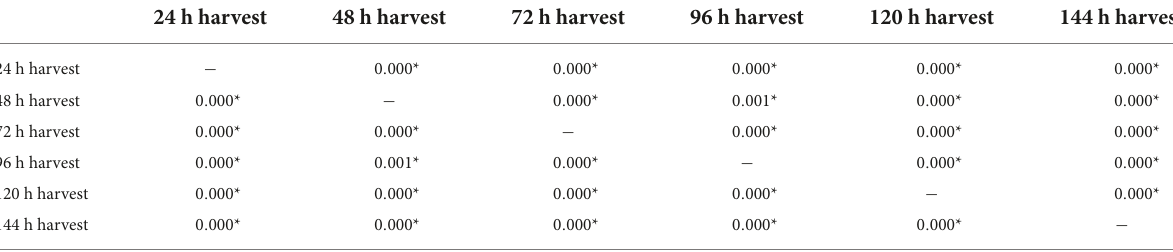
TABLE 7 Pairwise comparison of the harvests for total phenolics by Scheffe post hoc test.